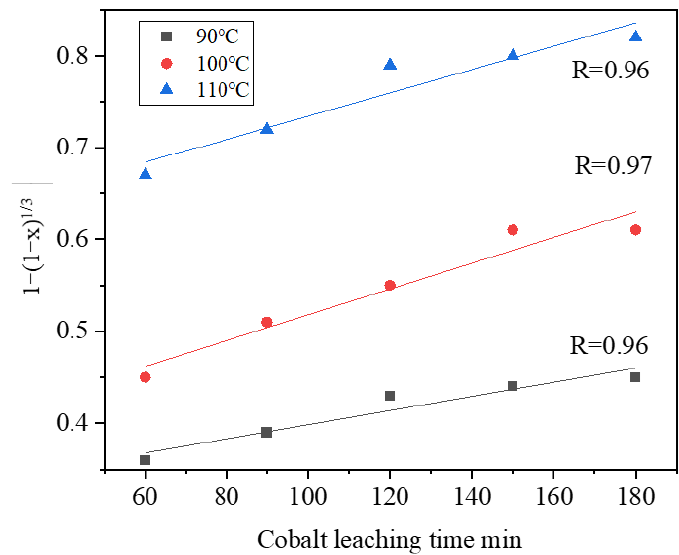
Figure 10. Kinetic curves of Co leaching at different temperatures.